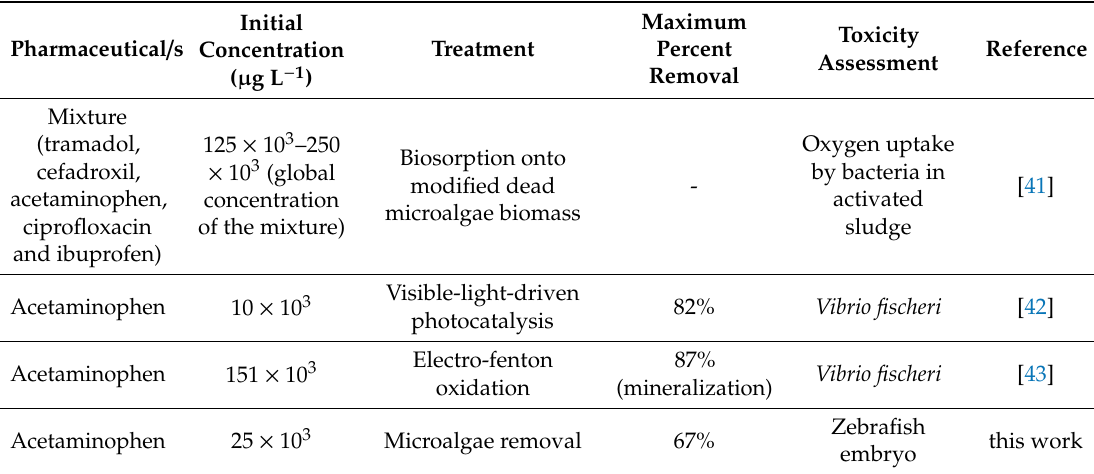
Table 3. Published approaches to evaluate treatment e ffi ciency in the removal of acetaminophen by complementing analytic information by toxicity assessments.